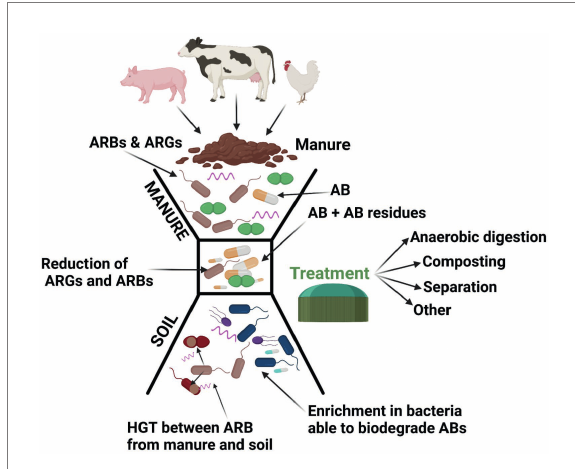
FIGURE 5 Effects of manure treatment on ABs and ARB, ARGs. The figure is created using